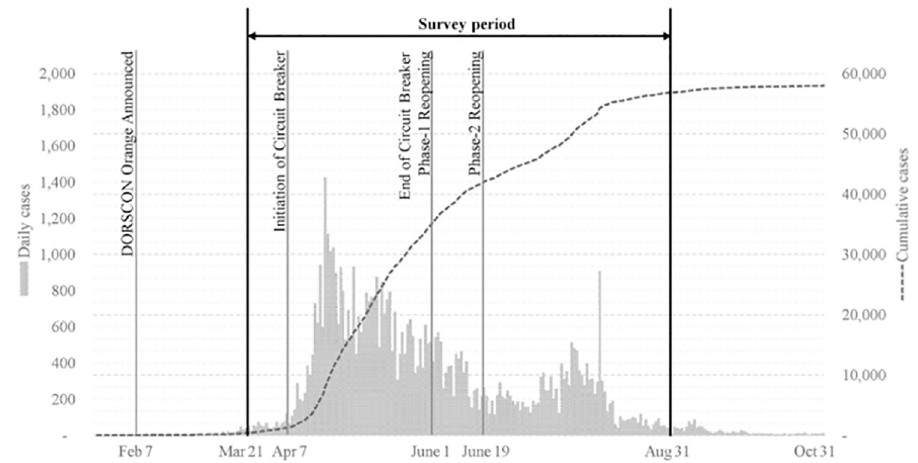
Fig 1. Timeline of COVID-19 cases in Singapore and study survey